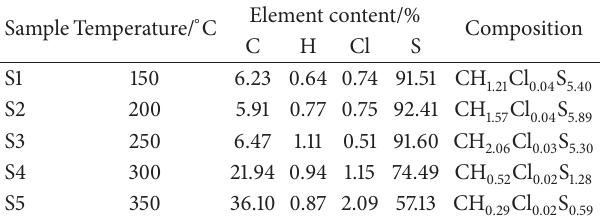
Table 1: Elemental analysis result of the products prepared by co- heating carbyne and sulfur at different